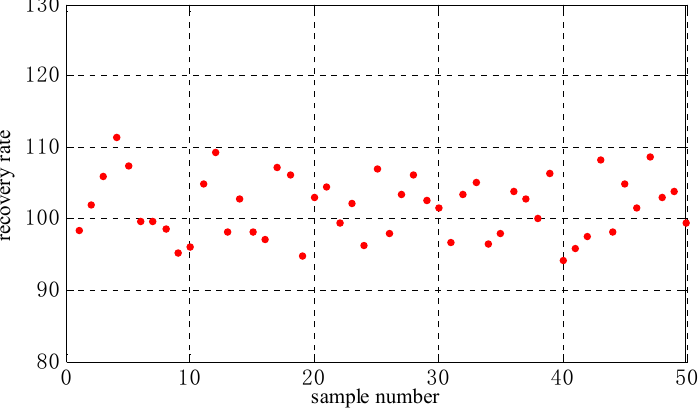
Figure 12. The recovery rate of CSO-SVM.